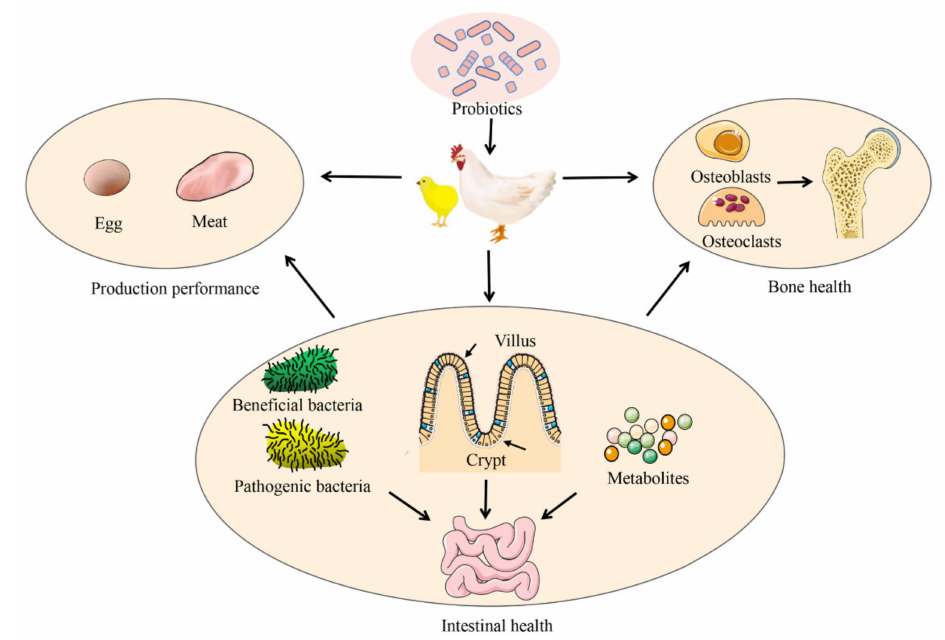
Figure 1. Application of probiotics in broiler